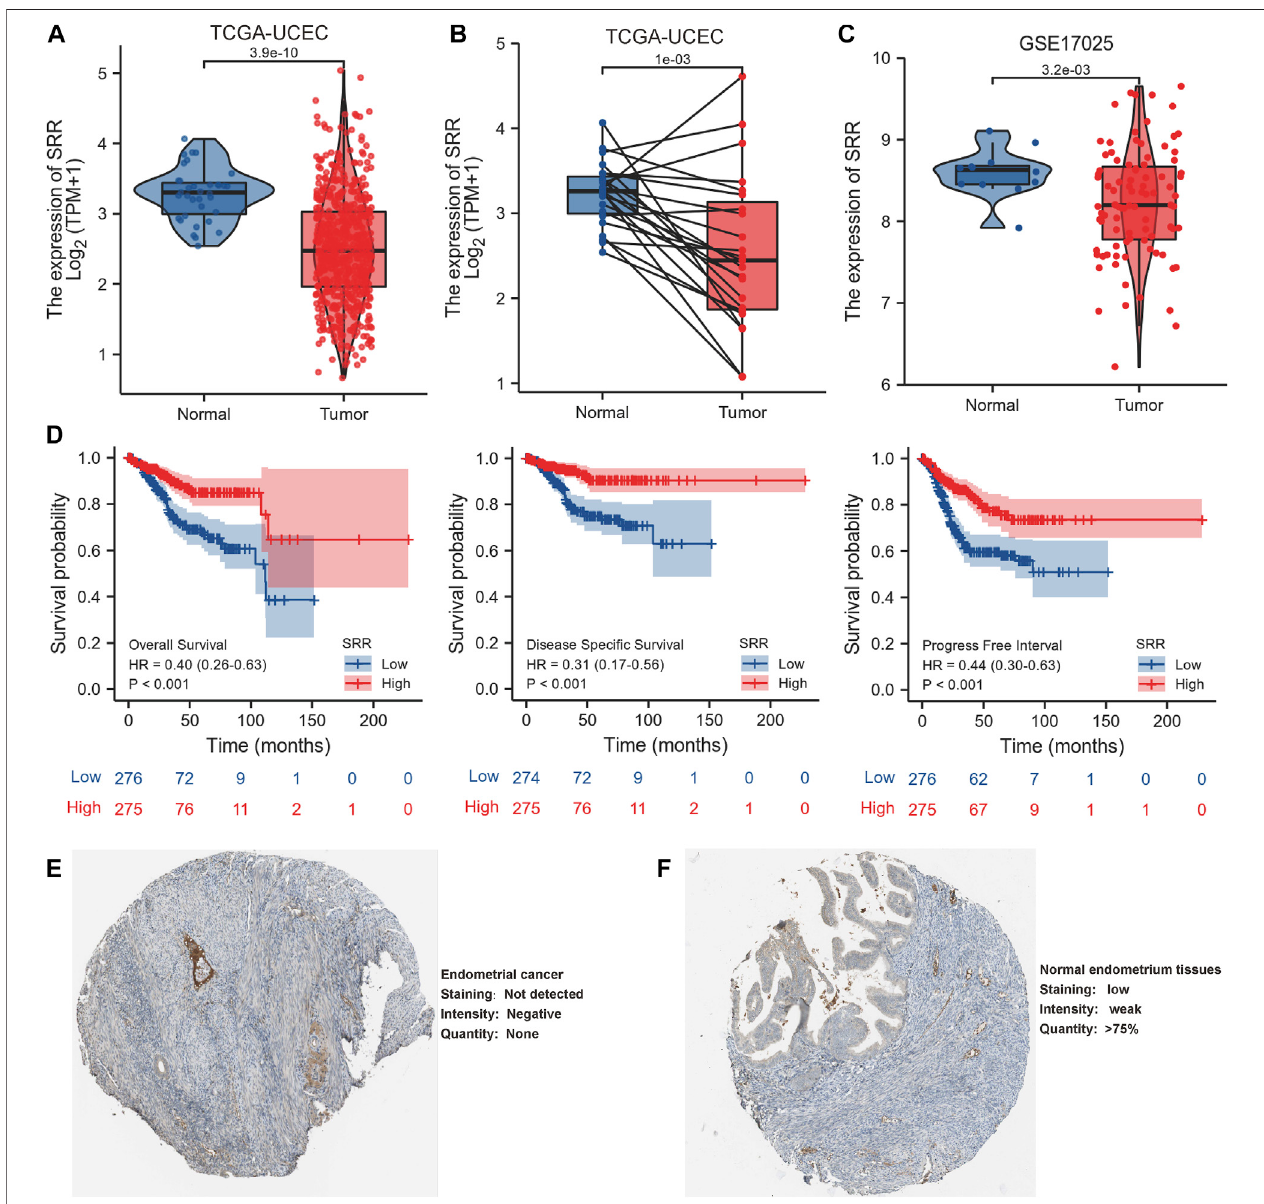
FIGURE 2 | Expression and prognostic value of SRR in UCEC. (A) SRR mRNA expression level in UCEC tissues ( n = 552) compared with normal tissues ( n = 35). (B) SRRmRNAexpression islowerinUCECtissuesthaninpairedadjacentnormal tissues( n =23). (C) ValidationofSRRexpression byanalyzingdatafromGSE17025. (D) OS, DSS, and PFI survival Kaplan-Meier curves of SRR in TCGA - UCEC patients. (E,F) Validation of SRR at the translational level using HPA database